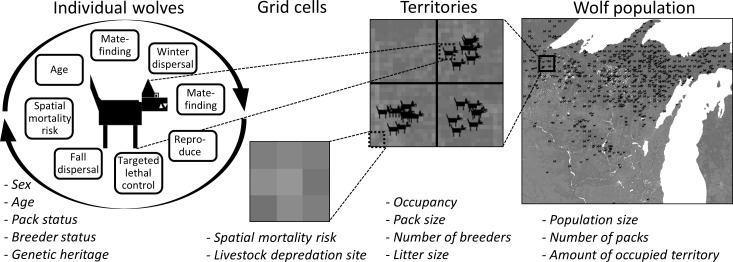
Depiction of an individual-based spatially explicit model for growth of the southern Lake Superior wolf population [37].The hierarchical levels of organization are the individual wolves, grid cells that make up the landscape, territories, and wolf population and the lists (e.g., sex, age, pack status) are the variables that characterize each level.